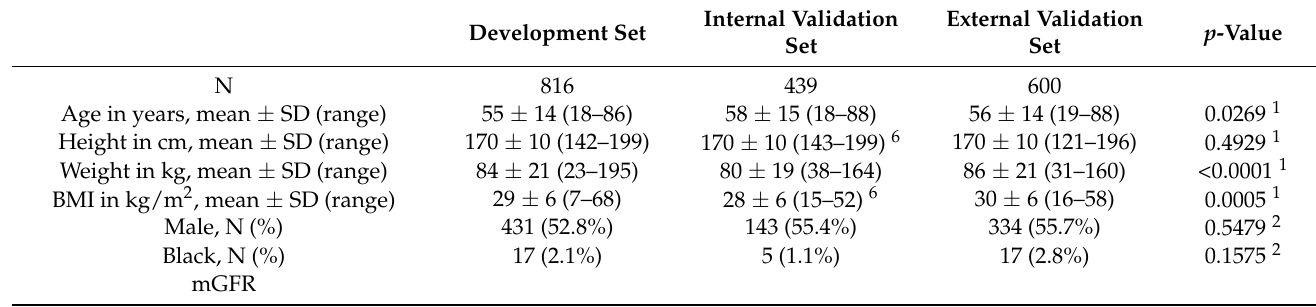
Table 1. Study samples’